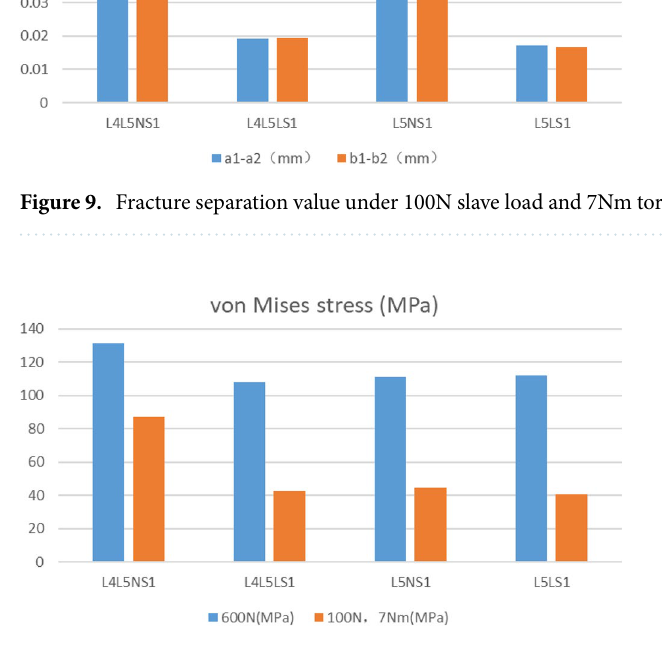
Figure 10. The Maximum von Mises